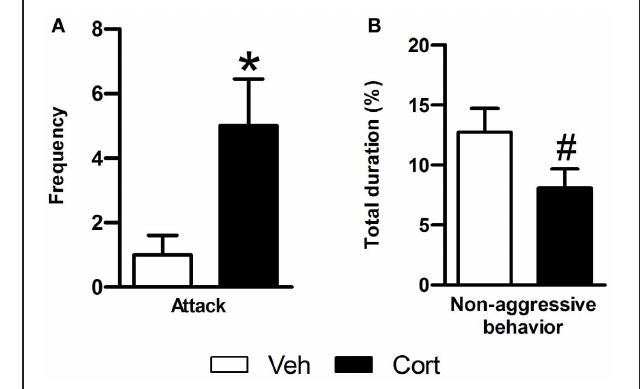
FIGURE 4 | Effect of corticosterone injections during peripuberty on aggressive behaviors in the resident intruder test in adulthood. (A) Attack number. (B) Percent duration of non-aggressive behavior. The results are expressed as mean ± SEM; ∗ p < 0 . 05, # p < 0 . 1; N = 11 for Veh and 12 for Cort group.